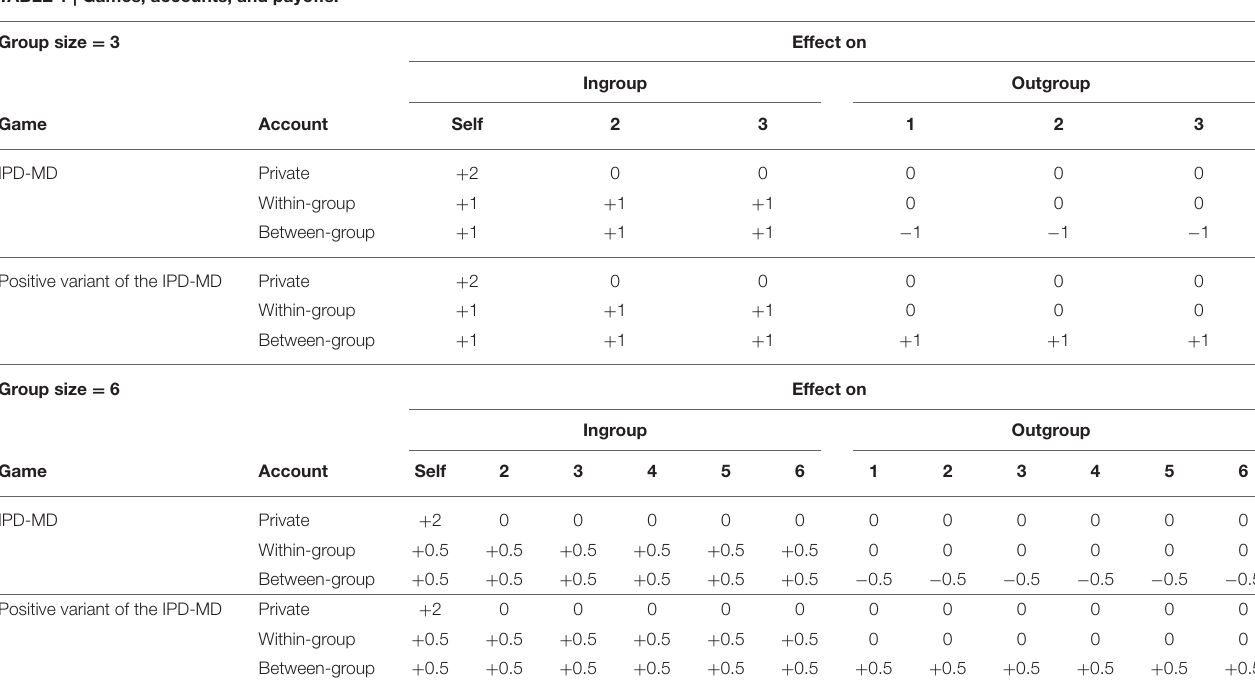
TABLE 1 | Games, accounts, and